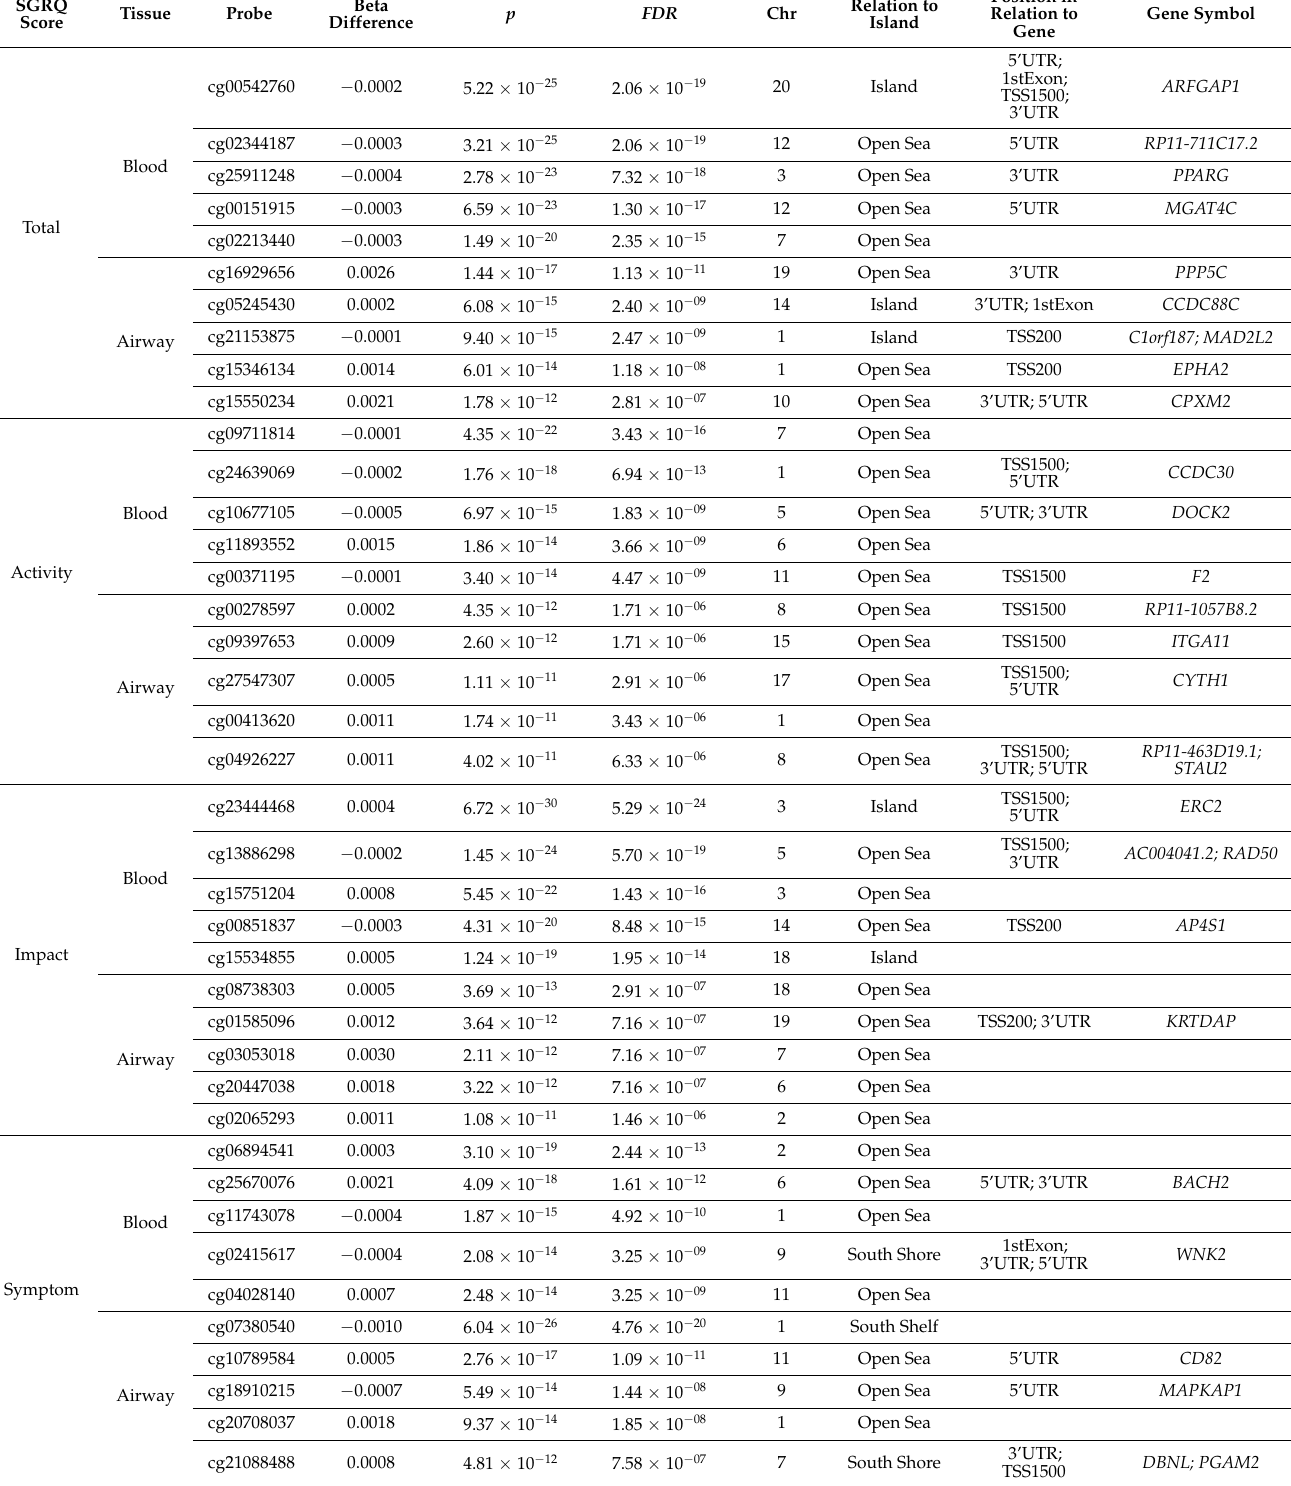
Top CpGs criteria: smallest to largest FDR. Beta difference was estimated from each methylation site beta value and p -value was estimated from each methylation site M-value. Negative beta: for each unit of SGRQ increased, DNA methylation decreases. Positive beta: for each unit of SGRQ increased DNA methylation